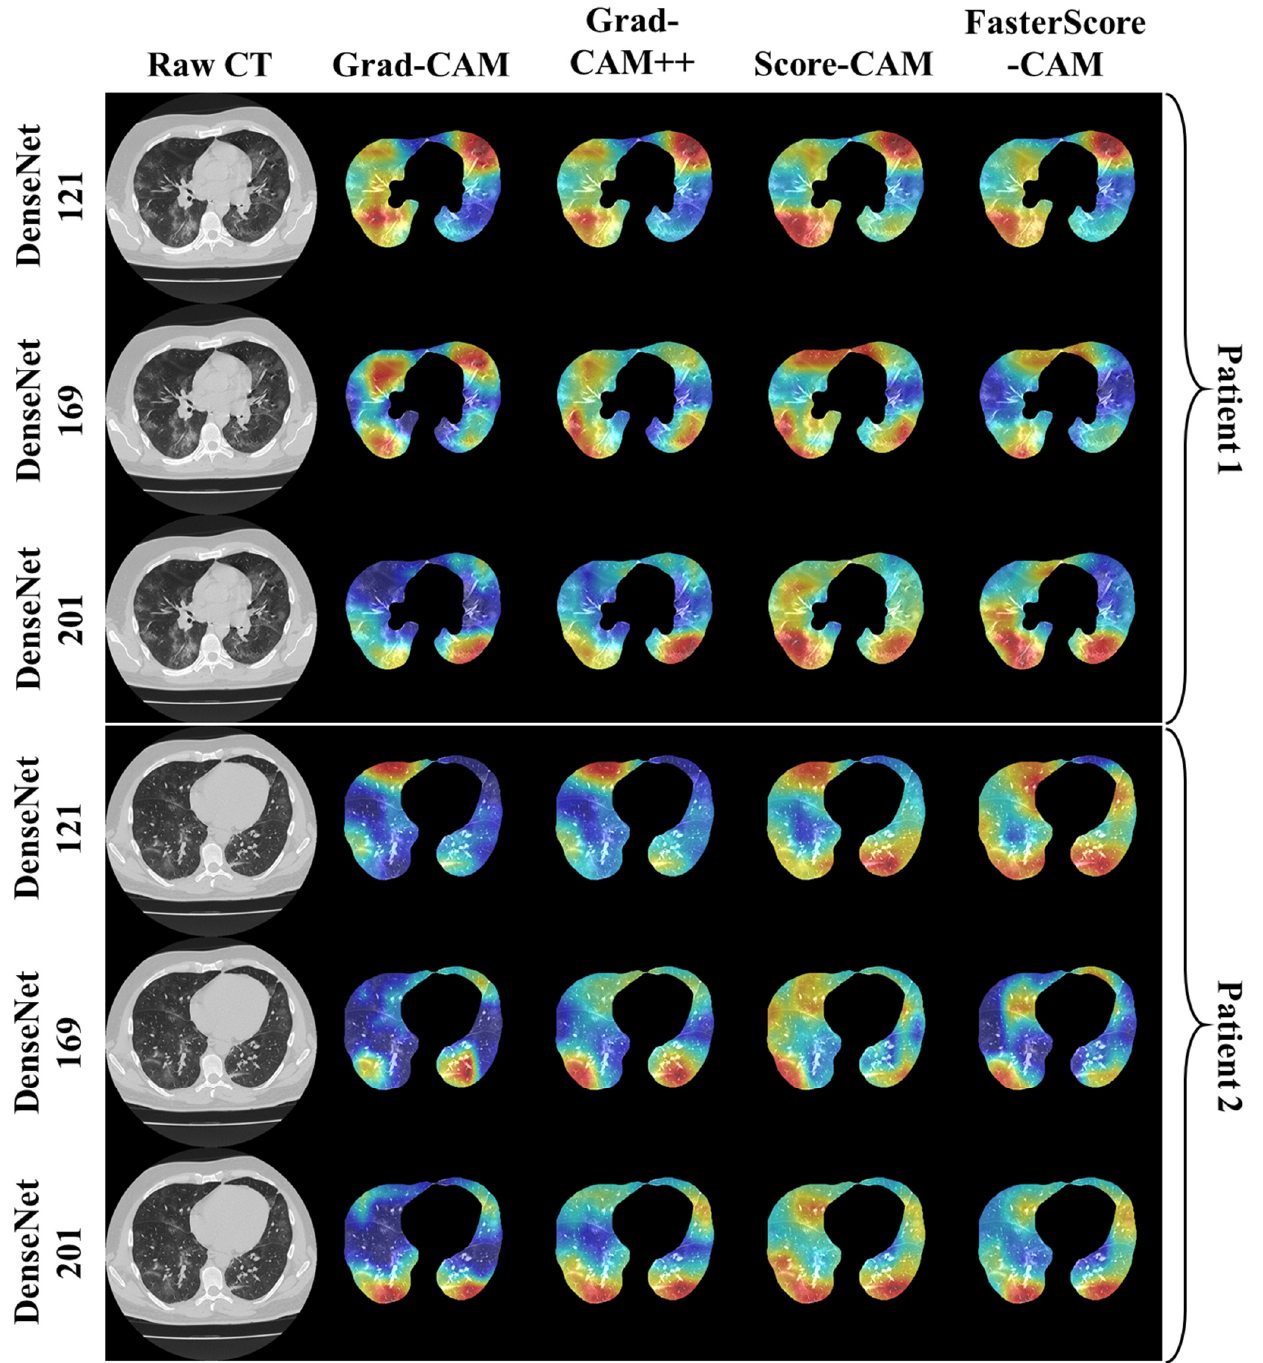
Figure 10. Heatmap using four CAM techniques using three kinds of DenseNet classifiers on COVID-19 lesion images. The top row is the CT slice for patient 1, and the bottom row is the CT slice for patient 2.